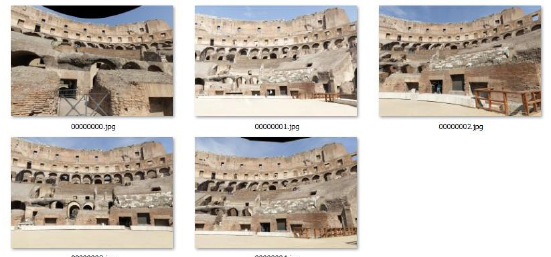
Figure 9. Five Rectilinear projections of the same inner part, acquired from the five inside panoramas by means of VR